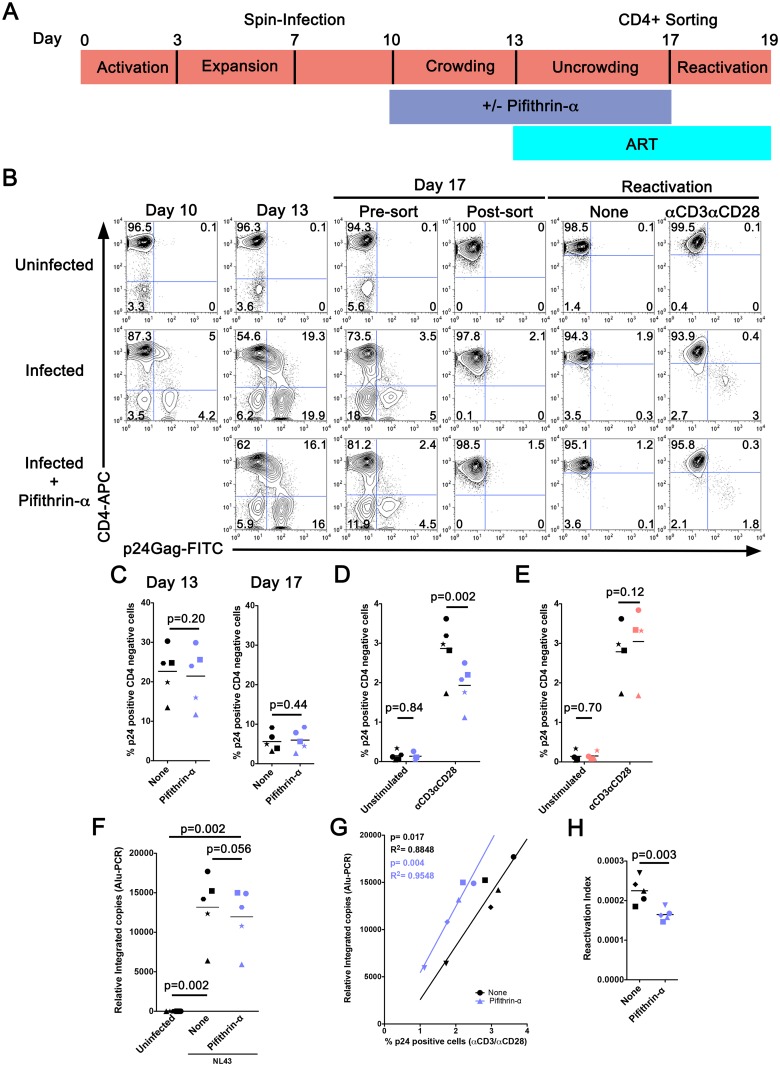
Effect of pifithrin-α upon establishment of latency.(A) Time-line of experimental procedures for pifithrin-α treatment of the latently infected (LI) condition. For the majority of experiments pifithrin-α was maintained in culture from day 10 to 17. (B) CD4 and p24 Gag staining from a representative donor throughout the experiment. Numbers in dot-plots represent percentages. (C) p24 Gag positive CD4 negative cells from 5 independent donors at day 13 and day 17 in cells treated (purple symbols) or untreated (black symbols) with pifithrin-α. (D) p24 Gag positive CD4 negative cells at day 19 following reactivation of LI cells with αCD3/αCD28 beads at day 17 in cells previously treated (purple symbols) or untreated (black symbols) with pifithrin-α (day 10 to 17). As a negative control, p24 Gag positive CD4 negative cells were also assessed in unstimulated cells treated with pifithrin-α in a similar manner. (E) In a deviation from the time-line presented in (A), pifithrin-α was added only during the reactivation period from day 17 to 19. p24 positive CD4 negative cells were then determined at day 19 following reactivation of LI cells that were treated (salmon symbols) or untreated (black symbols) with pifithrin-α. As a negative control, p24 Gag positive CD4 negative cells were also assessed in unstimulated cells treated with pifithrin-α in a similar manner. (F) HIV-1 integration analysis in LI cells at day 17 using Alu-PCR with 250 ng of genomic DNA. As a negative control, HIV-1 integration was also assessed in uninfected cells. (G) Correlation of integrated HIV-1 with the percentage of p24 Gag positive CD4 negative cells after reactivation with αCD3/αCD28 beads. Correlation was determined using the Pearson correlation coefficient. Black symbols represent untreated samples and purple symbols represent cells treated with pifithrin-α from day 10 to 17. (H) Reactivation index calculated as the percentage of cells expressing p24 (day 19) after αCD3/αCD28 reactivation divided by the number of integrated copies before reactivation (day 17). Throughout this figure each donor is represented with a different symbol and significance was determined with a paired t-test (p-values provided).